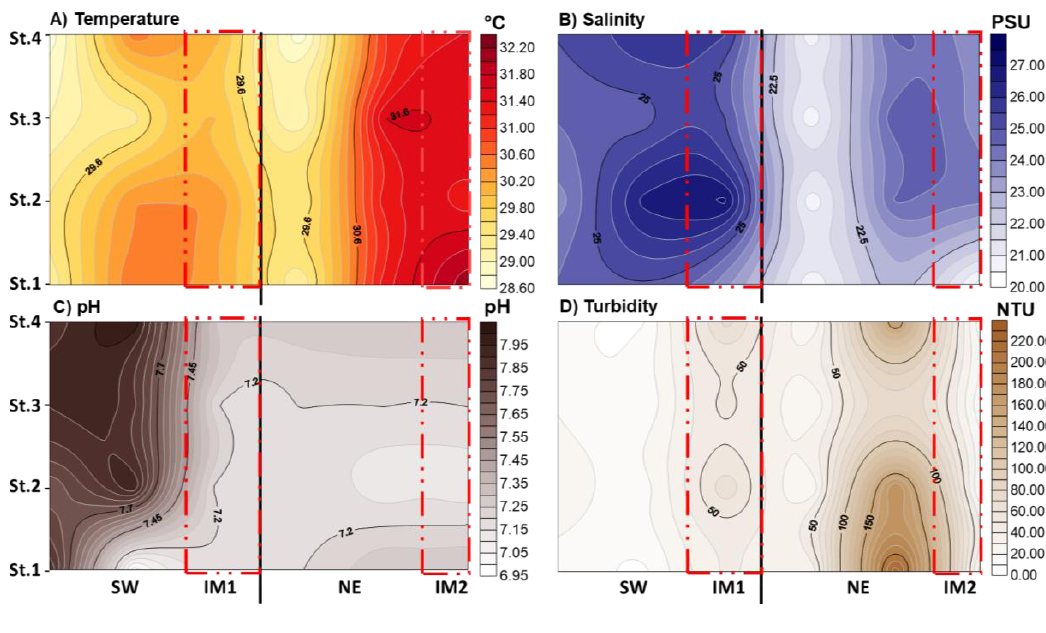
Figure 8. Seasonal changes of ( A ) temperature, ( B ) salinity, ( C ) pH, and ( D ) turbidity at different sites in the Sangga Kechil estuarine-mangrove area during the study period. J. Mar. Sci. Eng. 2020 , 8 , x FOR PEER REVIEW